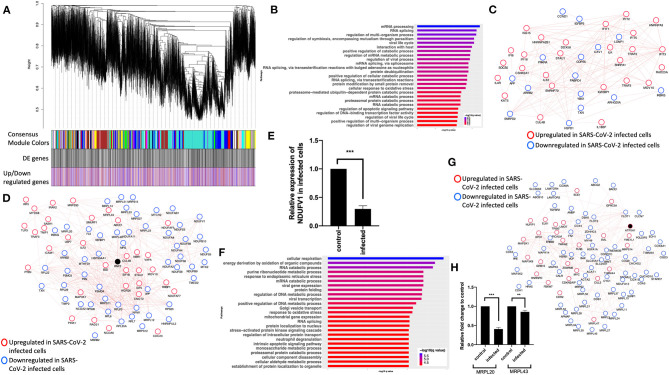
Consensus network analysis of hACE2-transduced mock and SARS-CoV-2-infected (high and low MOI) A549 cells. (A) Cluster dendrogram showing correlated genes grouped into clusters marked by different colors on the horizontal block labeled “Consensus Module Colors.” The DE genes in each cluster is marked as a black vertical line in the horizontal block labeled “DE genes.” The up- and downregulated genes are shown as red and blue vertical lines in a block labeled “Upregulated/downregulated genes,” respectively. (B) Top pathways from the pathway enrichment analysis of correlated DE genes in the blue module is presented as a horizontal bar plot, where the x axis represents the –log10-transformed q-value and the color of the horizontal bar is scaled blue to red representing low to high q-values, respectively. (C) Protein–protein interaction (PPI) subnetworks in the blue module is presented where each node represents a gene and the border color of the nodes indicate upregulation (red) and downregulation (blue) in SARS-CoV-2-infected A549 cells (high MOI) compared to mock-infected cells. The edge between the nodes indicate interaction based on the GeneMANIA database information. The network shows a highly connected interactome of interferon-stimulated genes (ISGs) that are coordinately upregulated in infected cells. (D) Another PPI subnetwork identified in the blue module shows several highly interconnected mitochondrial ribosomal (MRP) and complex I (NDUF) genes. Each node represents a gene and the border color of the nodes indicate upregulation (red color) and downregulation (blue) in SARS-CoV-2-infected A549 cells (high MOI) compared to mock-infected cells. Additional interactome of MYD88 TRAF3 and TLR3 genes that were coordinately upregulated in infected cells can be seen (top left). (E) NDUFV1 transcript level reported as fold change in beta-coronavirus-infected HCT-8 cells compared to control (no infection) HCT-8 cells. Student's t-test p-value = 2E-07. (F) Top pathways from the pathway enrichment analysis of correlated DE genes in the turquoise module is presented as a horizontal bar plot, where the x axis represents the –log10-transformed q-value and the color of the horizontal bar is scaled blue to red representing low to high q-values, respectively. (G) MRPL20 and MRPL43 transcript levels reported as fold change in beta-coronavirus-infected HCT-8 cells compared to control (no infection) HCT-8 cells. Student's t-test p-value = 8E-08 and 0.007. (H) A PPI subnetwork of correlated DE genes in the turquoise module shows a well-connected interactome of genes encoding mitochondrial ribosomal proteins, mitochondrial coiled-coil-helix-coiled-coil-helix domain proteins, and cytochrome oxidase. Each node represents a gene and the border color of the nodes indicates upregulation (red color) and downregulation (blue) in SARS-CoV-2-infected cells (high MOI) compared to mock-infected cells. DE, differentially expressed; MOI, multiplicity of infection.